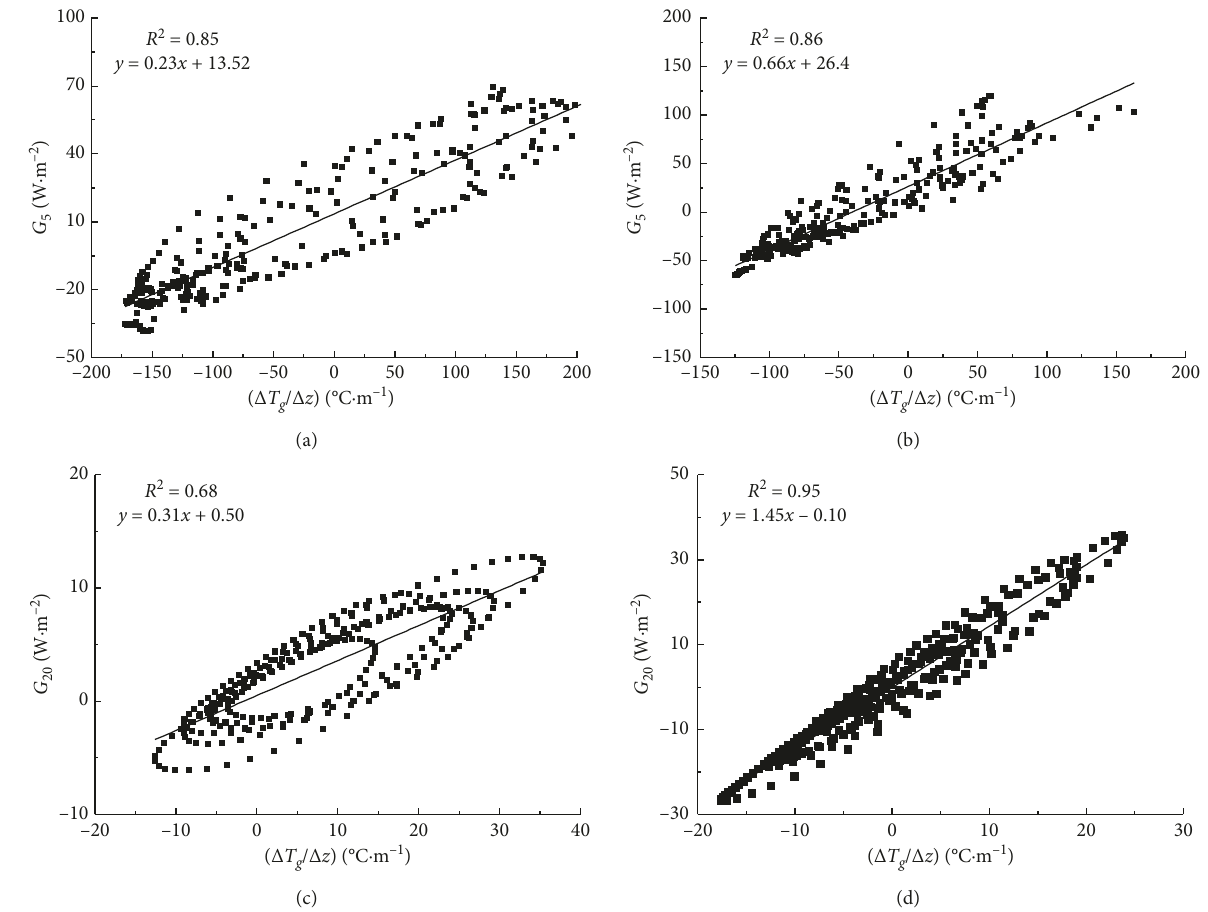
Figure 8: Variations in the soil thermal conductivity before and after rainfall: (a) 5cm depth before rainfall; (b) 5cm depth after rainfall; (c) 20cm depth before rainfall; (d) 20cm depth after